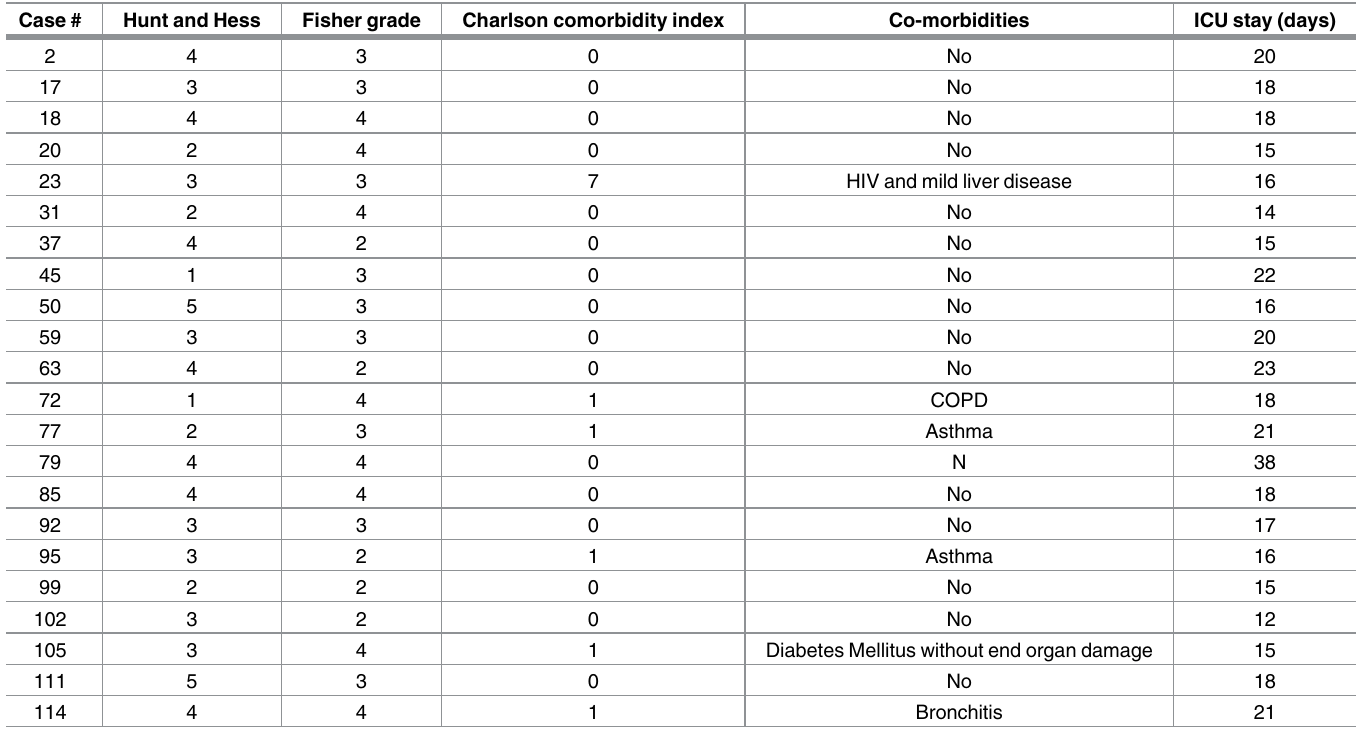
Table 2. Clinical Characteristic of Patients Who ReceivedIA